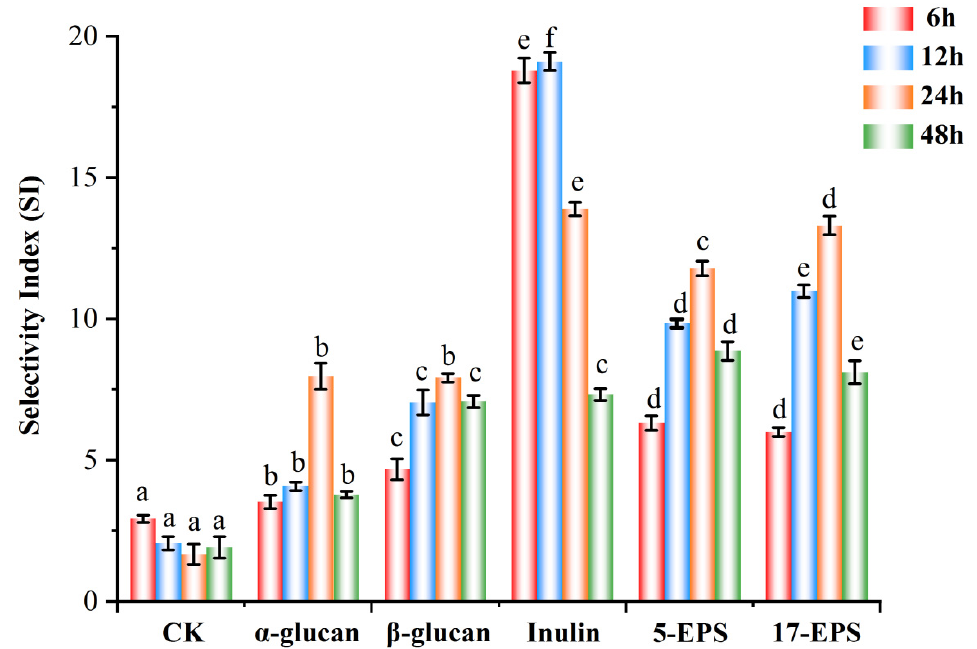
Figure 4. Comparison of the selectivity index (SI) values for α -glucan, β -glucan, LHEPS, LPEPS, and inulin at 6, 12, 24, and 48 h in vitro anerobic fermentation. Statistically significant differences ( p < 0.05) were denoted by corresponding lowercase letters (a, b, c, d, e, and f) using different polysaccharides as a substrate at the same time points. The error bars show the standard deviations.